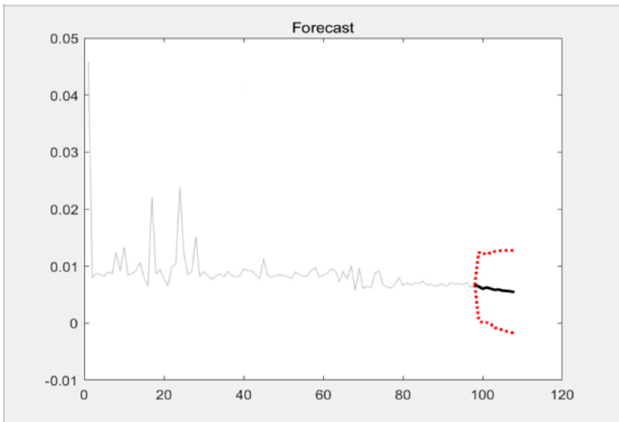
Figure 17. Confidence interval of the predicted value.